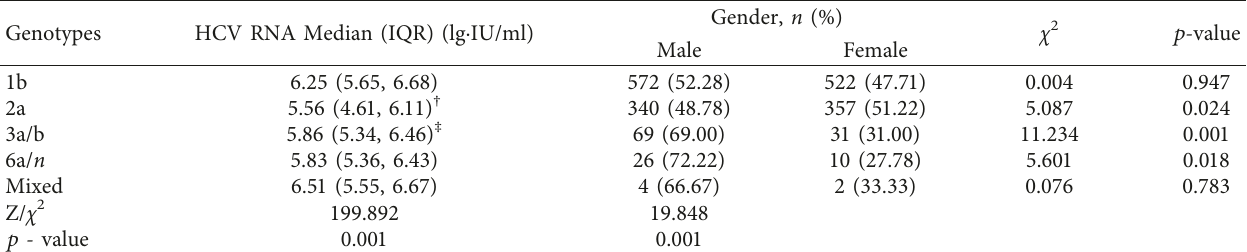
Table 3: HCV viral load in different genotypes and gender-wise genotype distribution in HCV-infected